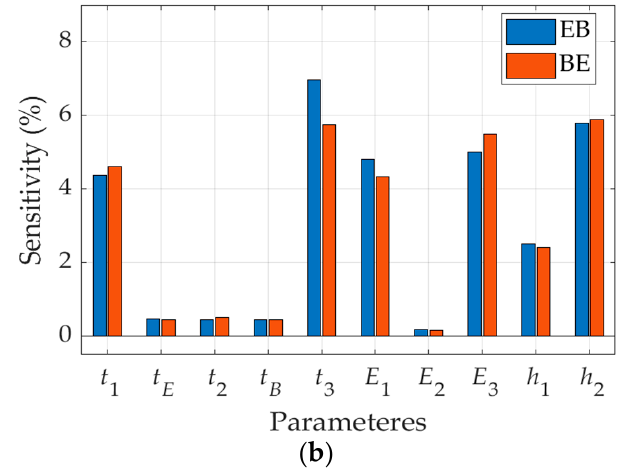
( f ) Figure 13. The sensitivity analysis of BS in EB and BE configuration with respect to all layers’ thick- nesses, 𝑡 (cid:3036) , elastic properties of liners, 𝐸 (cid:3036) and flute geometric parameters, ℎ (cid:3036) : ( a ) Board 1; ( b ) Board 2; ( c ) Board 3; ( d ) Board 4; ( e ) Board 5; ( f ) Board 6.